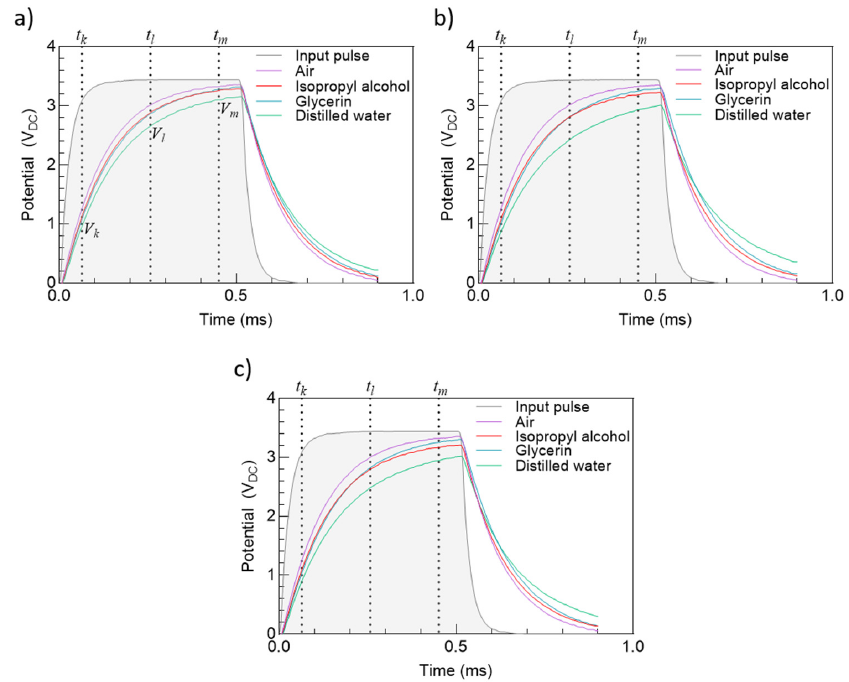
Figure 13. Transducers response to input pulse for different testing fluids: ( a ) IDEA 1, ( b ) IDEA 2, and ( c ) IDEA 3.